Question: State the chart type depicted above.
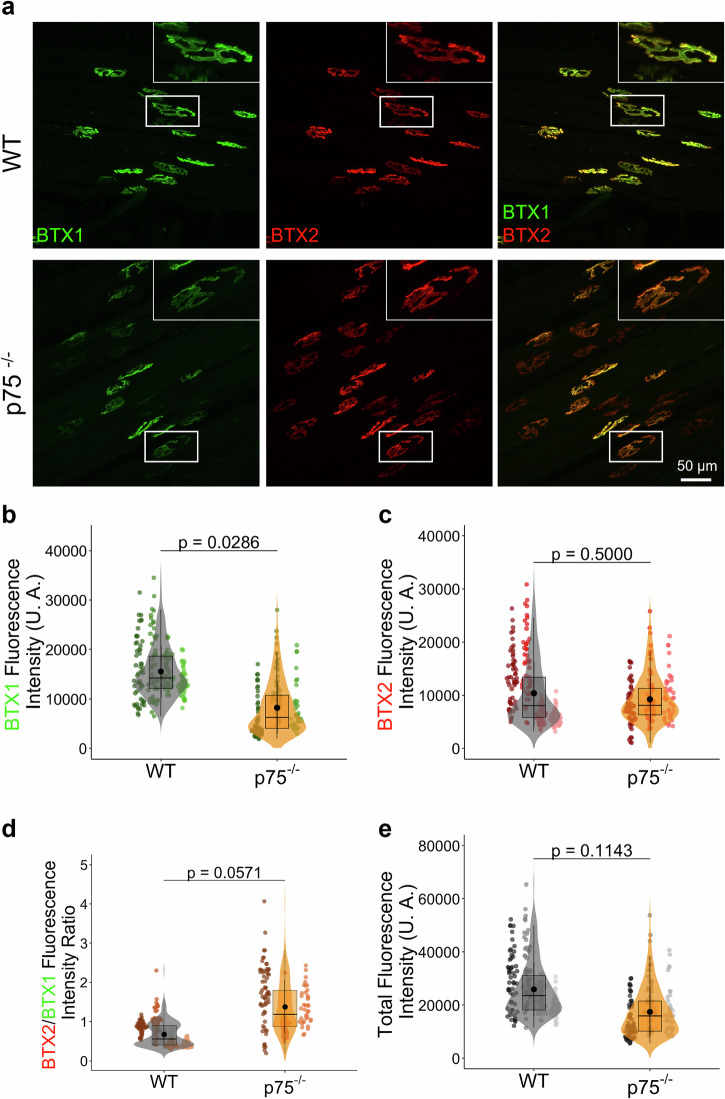
Answer: box